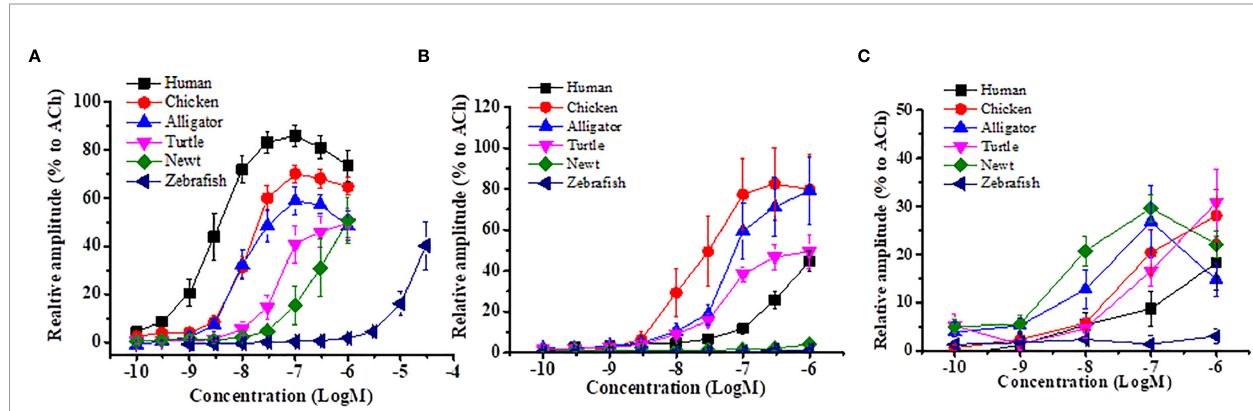
FIGURE 2 | Comparison of contractile ef fi cacy of different vertebrate motilins in isolated muscle strips from rabbit duodenum, chicken ileum and Japanese fi re belly newt stomach. Isolated GI muscle strips from each animal were incubated in an organ bath containing bubbled physiological salt solution. Motilins were applied in the organ bath and evoked muscle contractions were measured by a force-transducer. Using this equipment, GI muscle-contracting actions of human, chicken, alligator, turtle, newt and zebra fi sh motilins were compared in the isolated rabbit duodenum (A) , chicken ileum (B) and Japanese fi re belly newt stomach (C) . The symbols indicate concentration-response curves for the six motilins (human, chicken, alligator, turtle, newt and zebra fi sh). The Y axis indicates the relative amplitude of contraction normalized by the response of 10 -4 M acetylcholine. Each symbol indicates the means ± SEM of results of at least fi ve experiments. Homologous motilin showed the strongest response in respective GI strips (rabbit duodenum vs. human motilin; chicken ileum vs. chicken motilin; newt stomach vs. newt